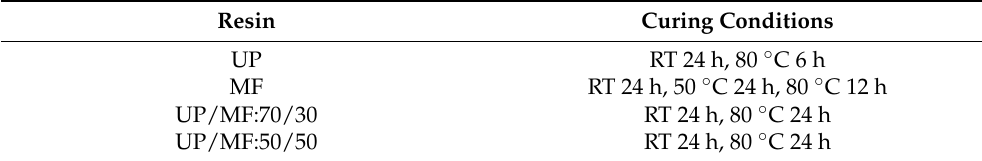
Table 1. Sample composition and curing